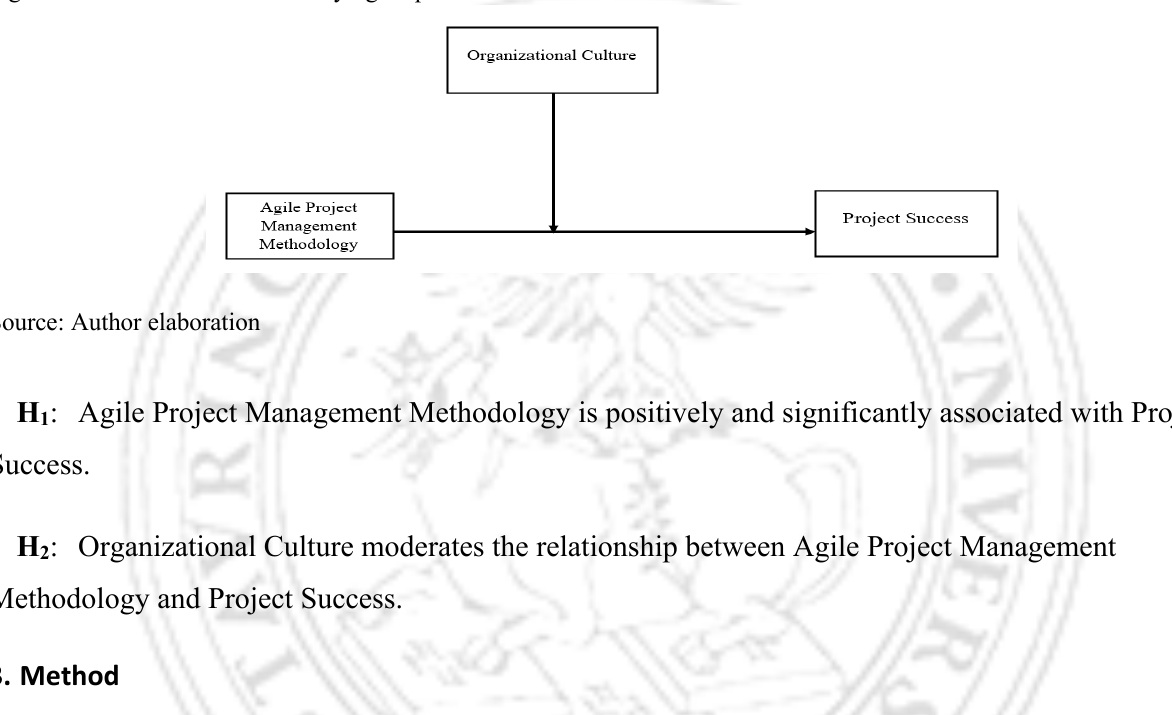
Figure 3 Theoretical Model underlying empirical